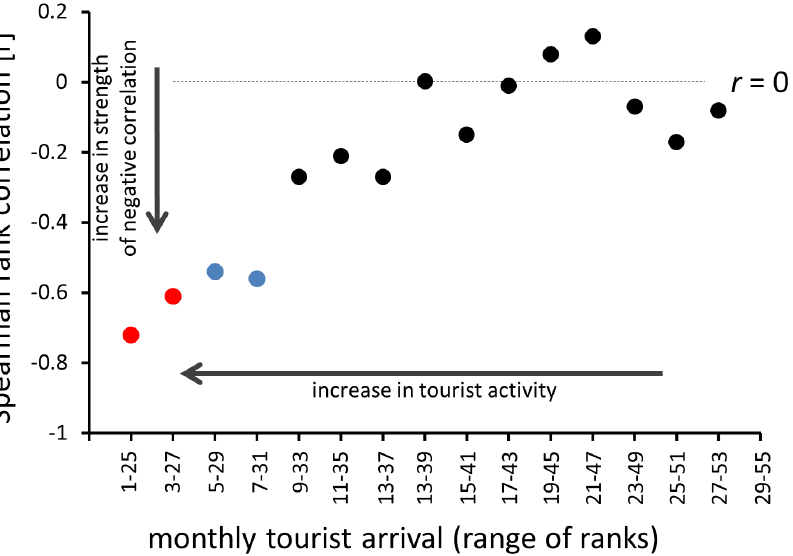
Figure 7. Changes in strength of rank correlation as a function of tourist activity. Monthly estimates are binned into 25-transect groups based on their rank in terms of tourist arrivals. The left endpoint along the x axis (ranks ‘‘1–25’’) represents the dataset restricted to 25 monthly transects with the highest tourist arrivals. The right endpoint (ranks ‘‘29–55’’) represent the 25 months with the smallest numbers of tourists. All restricted datasets are comparable in sample size ( n = , 25 transects) although due to tied ranks, some rank ranges represent 24 or 26 monthly transects. Red symbols are significant at p , 0.001 and blue symbols at p , 0.01.